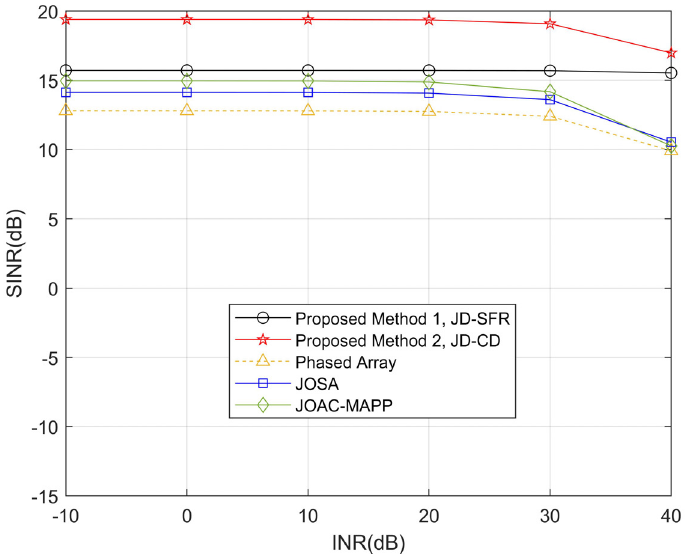
Figure 5. Compare the relationship between SINR loss and interference power obtained by the proposed methods and other methods for K = 3.